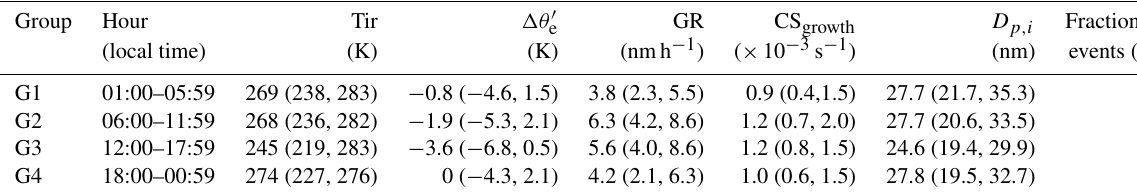
Table 2. Median and 25th and 75th percentiles (in parenthesis) for Tir, (cid:49)θ (cid:48) e , D p,i , GR, and CS growth for each hourly group. Tir, (cid:49)θ (cid:48) e , and D p,i correspond to the onset of the particle growth event.